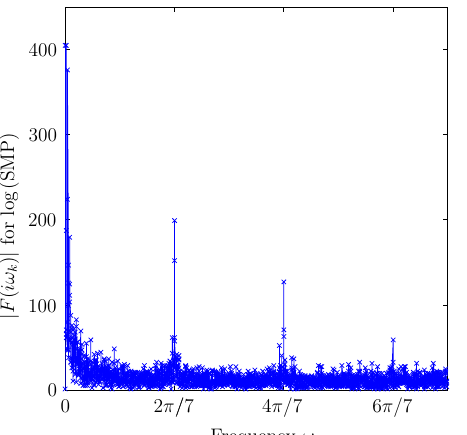
Figure 5. Periodogram for log(SMP). Author’s calculations. Notes: The periodogram plot for lsmp t T (cid:82) lsmp ( t ) e − i ω t dt and can be is based on the Fourier transform, which is defined as F ( i ω ) = · 0 T T 1 1 − − ∑ ∑ ( cos ω k t lsmp t e − i ω k t = lsmp t i sin ω k t ) = ( lsmp t ,cos ω k t ) approximated as F ( i ω k ) ≈ · · − − t = 0 t = 0 i ( lsmp t ,sin ω k t ) , where ω k = k 2 π , k = 0,1,2, . . . , N 1, and N determines the grid. The N 1 · − − expressions in parentheses represent scalar products, which in statistical terms measure covariation between lsmp t and cosine or sine functions for different values of ω k . In this optimization problem, our task is to find such values of ω k that would explain a large portion of variation in lsmp t . The Fourier transform suggests that frequencies 2 π /7, 4 π /7, and 6 π /7 with cosine and sine functions F ( i ω k ) allow maximizing . We do not consider sin ( 6 π t /7 ) because correlation between sin ( 6 π t /7 ) | | and lsmp t is statistically